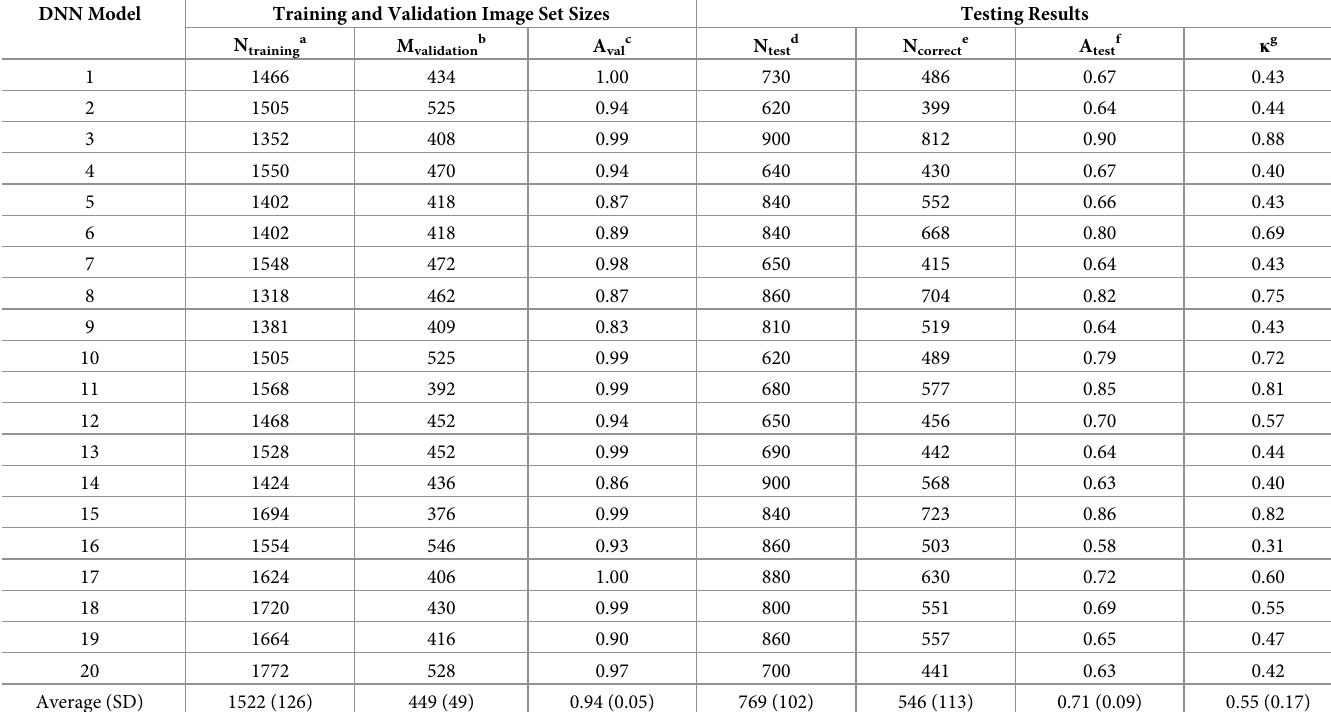
Table 7. Classification of 30 Abs that bind exclusively to one out three possible epitopes. Two binding sites recognized by Abs from Set 1 (ADI-15734 competitors) and Set 2 (ADI-15878 competitors) are located at the base of the EBOV-GP trimer, and the third epitope recognized by Abs from Set 3 (ADI-15974 competitors) is located at HR2/MPER region. All DNN models are based on evaluating fingerprint images based on the charge coloring code.